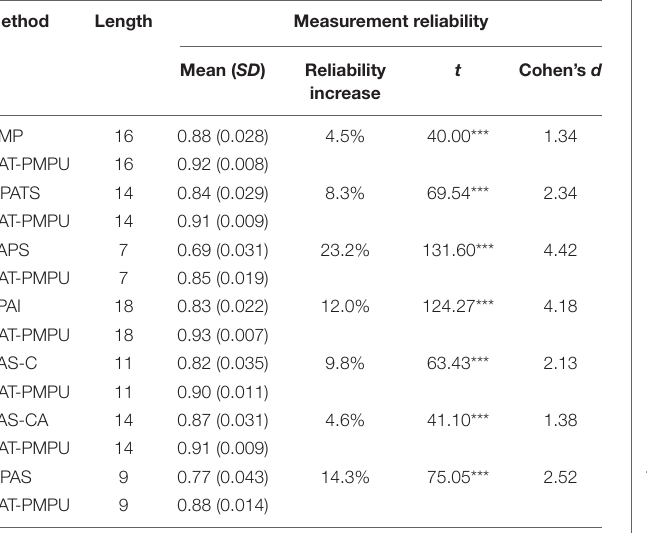
TABLE 6 | Measurement reliability of two test methods under same test